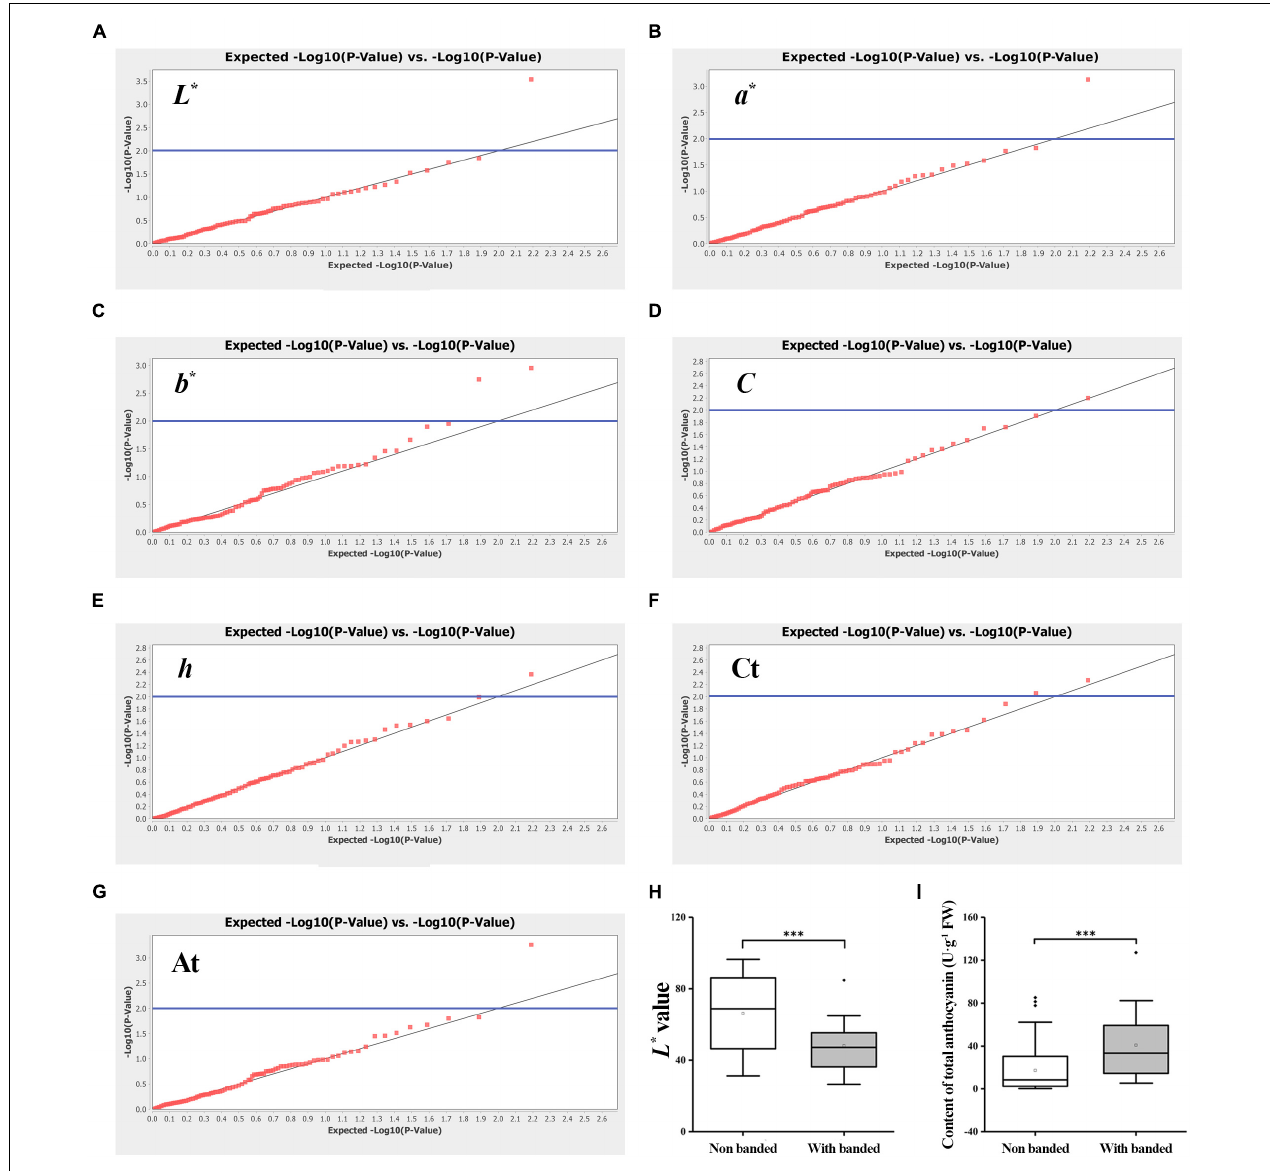
FIGURE 8 | Association analysis of EST-SSR markers with seven flower colors related traits among 123 gerbera accessions. (A) QQ plot of L* value. (B) QQ plot of a* value. (C) QQ plot of b* value. (D) QQ plot of C value. (E) QQ plot of h value. (F) QQ plot of total carotenoid content. (G) QQ plot of total anthocyanin content. Threshold: the blue line is P = 0.01. (H,I) Box chart analysis with L* value and total anthocyanin content of GEM65c locus. ∗∗∗ Denotes significant level of